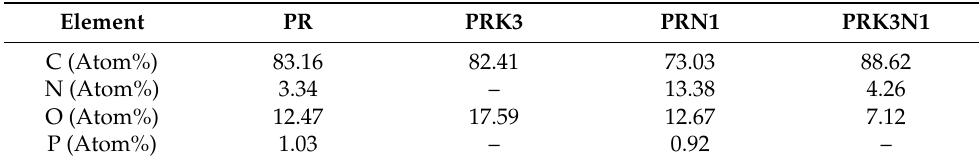
Figure 4. ( a ) Full XPS spectra of PR, PRK3, PRN1 and PRK3N1, and high-resolution ( b ) C 1s, ( c ) N 1s and ( d ) O 1s of PRK3N1. Table 2. The chemical compositions of all samples by XPS analysis.